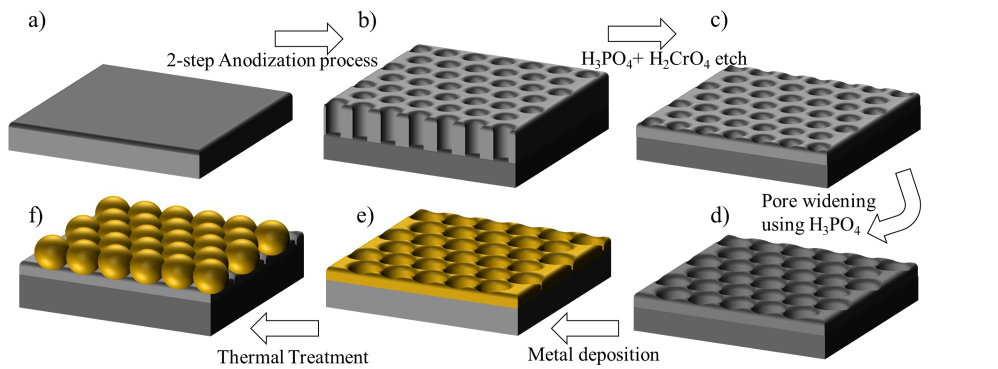
Figure 1. Schematic of the nano-dimpled Al surface ( a – c ) and synthesis of gold nanoparticle arrays ( e – f ). ( a ) Chemically polished Al foil; ( b ) Thick Al 2 O 3 layer grown on Al surface, following a 2-step anodization process; ( c ) Chemical etch to thin the Al 2 O 3 membrane to created a dimpled surface; ( d ) Dimpled Al 2 O 3 layer with widened pores; ( e ) Thermally evaporated thin metal film conformally coating the dimpled surface; ( f ) Synthesis of an array of metal nanoparticles formed after thermal